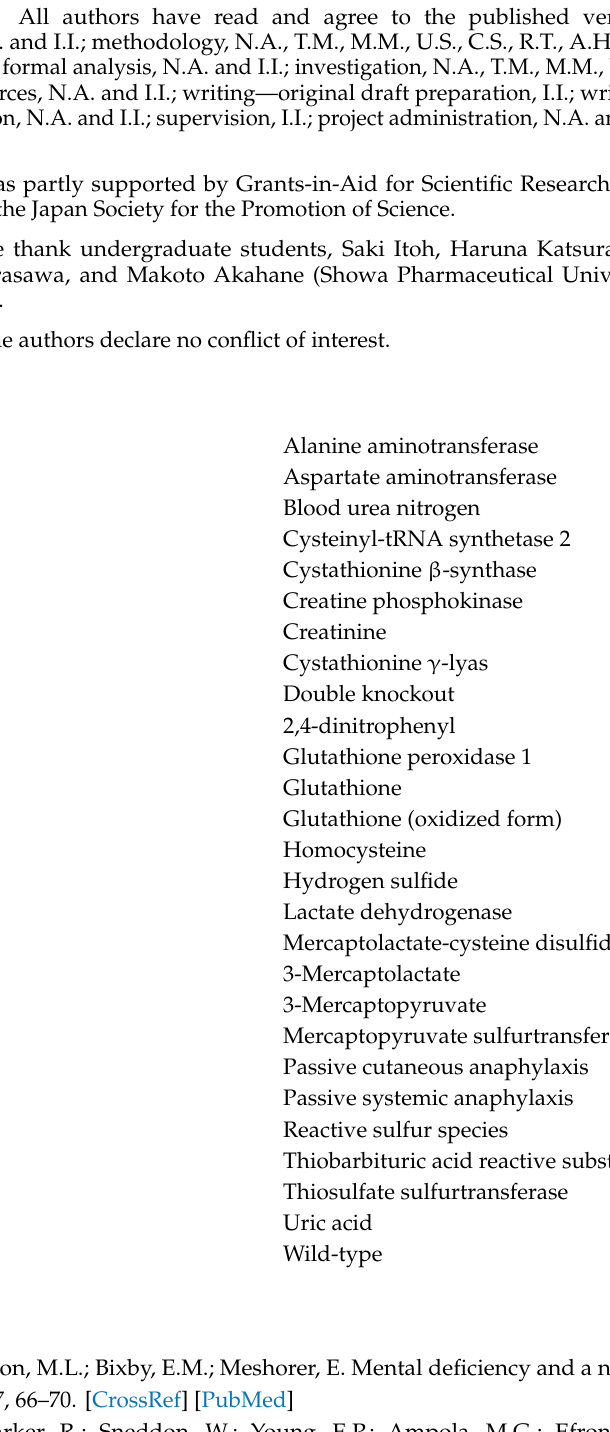
Figure S5: Representative chromatograms in the measurements of thiol compounds in serum samples, Figure S6: Representative chromatograms in the measurements of 3-mercaptolactate in urine